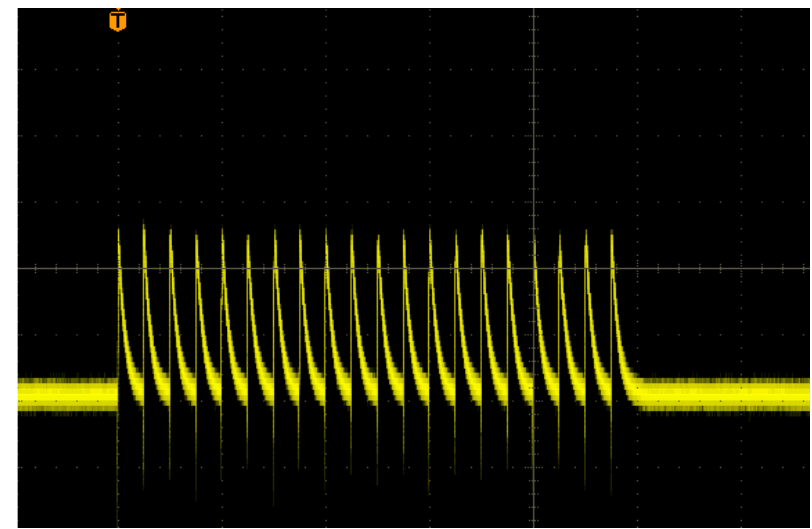
Figure 3. A 20 pulse lightning waveform.